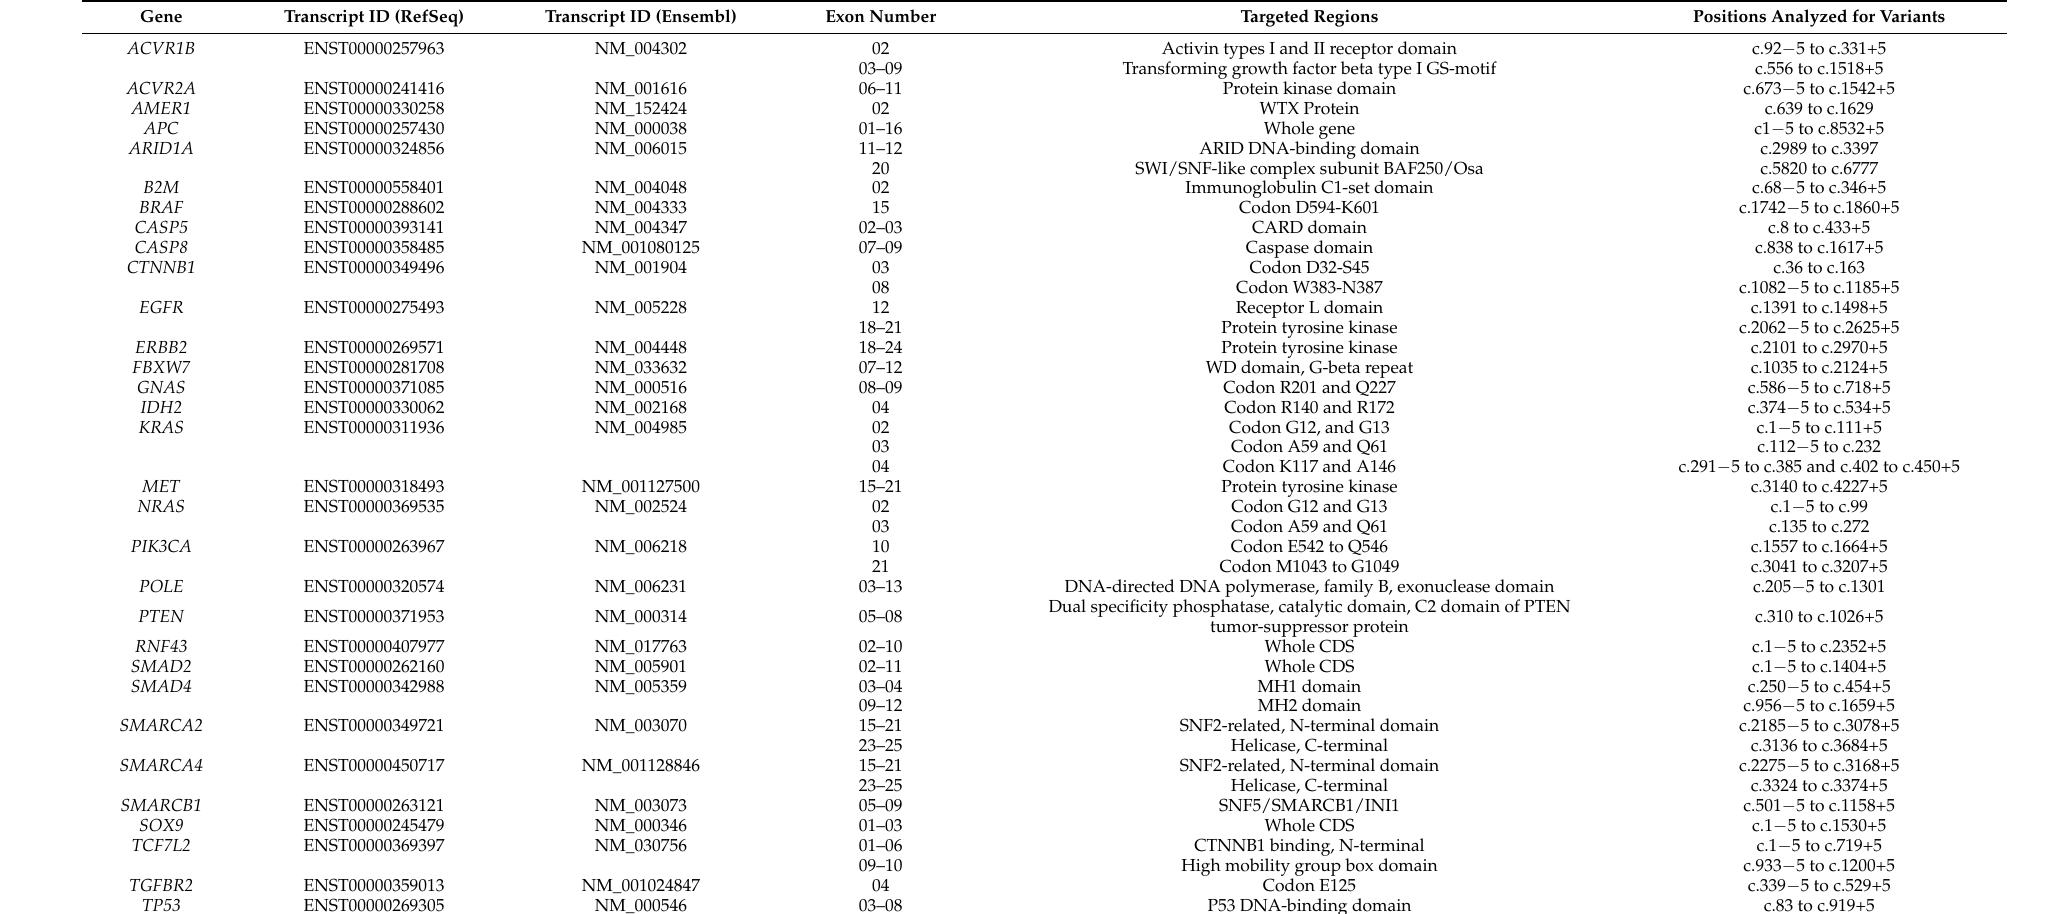
Table 1. Overview of regions targeted by Transcan smMIP